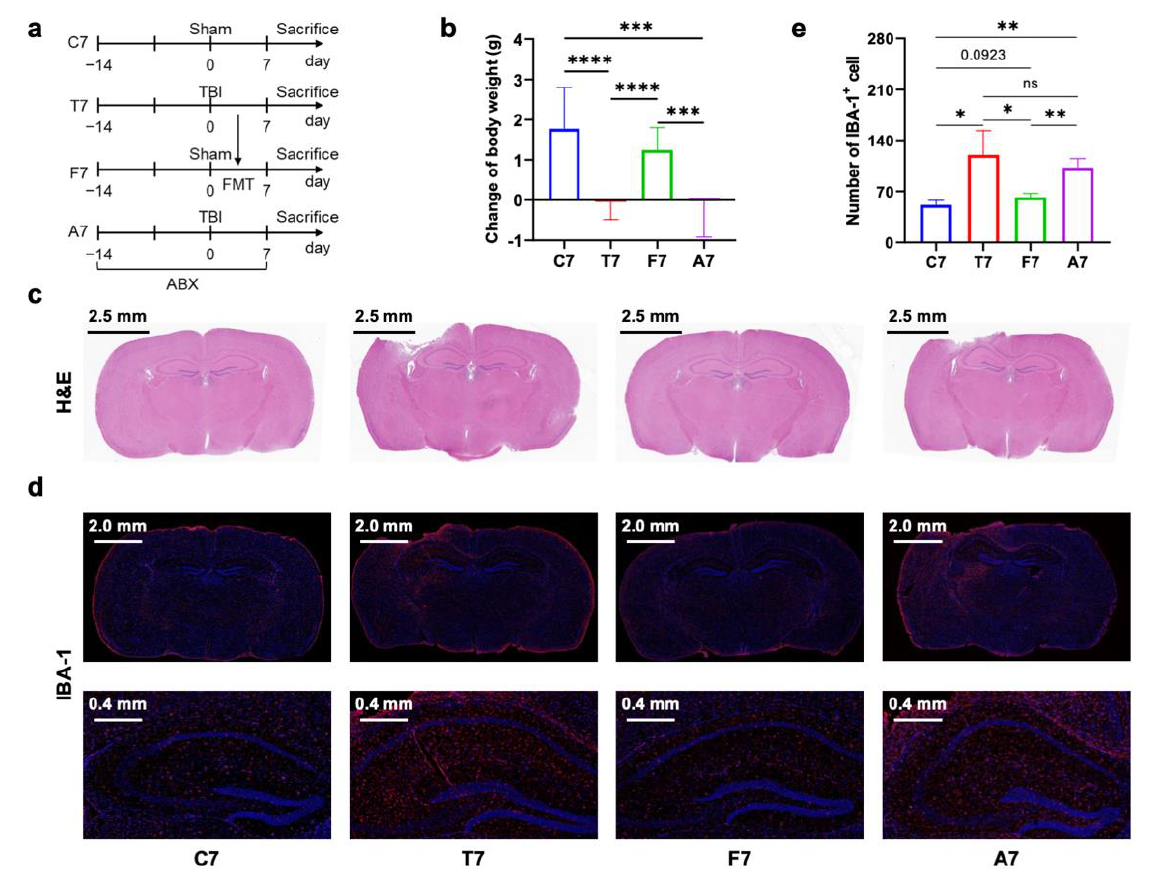
Figure 1. Design of the experiment and evaluation of brain injury and microglial activation at 7 days postTBI. ( a ) Design of the experiment ( n = 6 per group). Mice of group C7 received sham surgery, mice of group T7 were subjected to TBI surgery without perioperative antibiotic treatment, the mice of group F7 underwent sham surgery and FMT using fecal microbiota from the mice of group T7, and mice of group A7 were subjected to TBI surgery with perioperative antibiotic treatment. All mice were sacrificed 7 days after TBI for sample collection. ( b ) Change of body weight before and after TBI ( n = 6 per group). ( c ) Representative images of the brain H&E staining ( n = 3 per group). ( d ) Representative images of brain IBA-1 immunofluorescence staining (red) ( n = 3 per group). ( e ) Number of IBA-1 positive cells in hippocampus. Data are shown as mean ± SD. * p < 0.05, ** p < 0.01, *** p < 0.001, **** p < 0.0001 using unpaired Student’s t test. TBI, traumatic brain injury; H&E, hematoxylin – eosin; IBA-1, ionized calcium binding adapter molecule 1; ns, no significant.